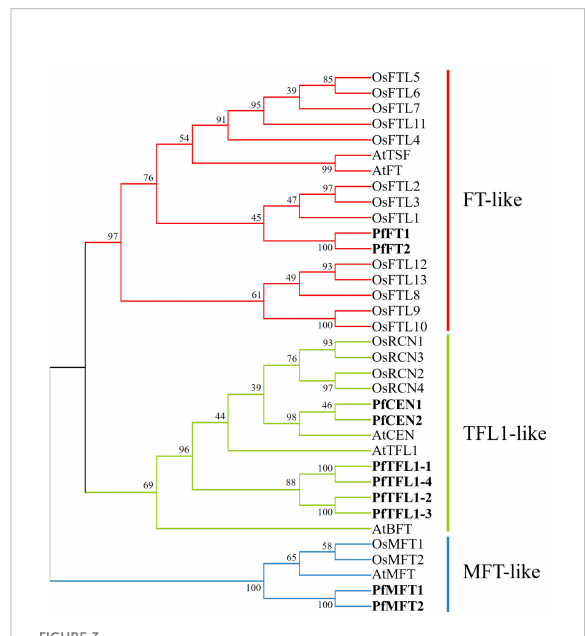
FIGURE 3 Phylogenetic relationship of PEBP in P. frutescens , A. thaliana , and O. sativa . The phylogenetic tree was constructed using the Neighbor-Joining method in MEGAX with 1000 bootstrap replicates. FT-like, TFL1-like, and MFT-like subfamilies were marked by red, green, and blue, respectively. PfPEBP were shown in bold font. GenBank accession number of each sequence was listed in Supplementary Table S2 and S3.